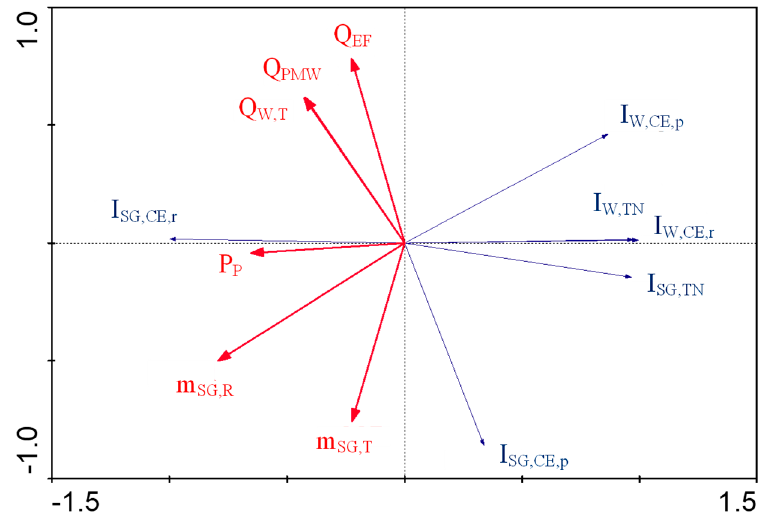
Figure 6. Triplot diagram for redundancy analysis of the indicators of technological nutrient (I i,TN ) and circular economy (I i,CE,r and I i,CE,p ) in relation to the operational variables Q EF (volumetric flow of treated water that can be recovered during the treatment process), Q PMW (volumetric flow of wastewater from the paper mill), Q W,T (total water volumetric flow consumed in the paper production process), P P (mass flow of paper produced), m SG,R (mass flow of recovered sludge during the wastewater treatment of the paper mill) and m SG,T (mass flow of generated sludge).